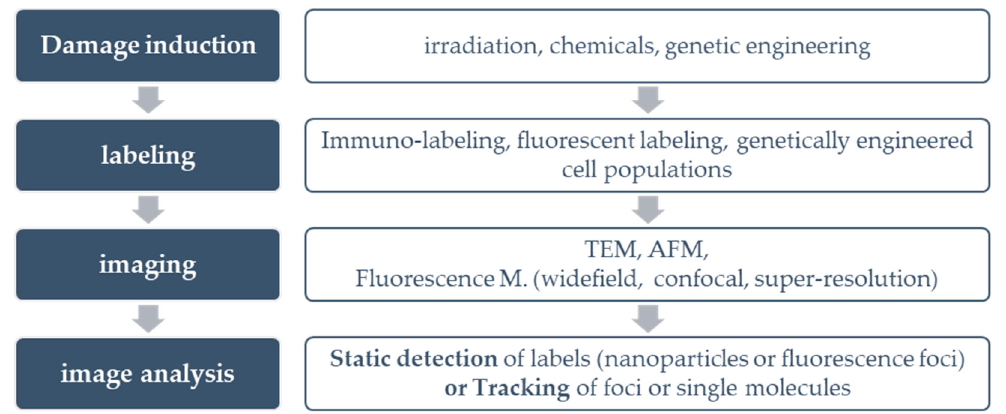
Figure 2. Synopsis of the common fundamental steps across DNA damage in situ detection